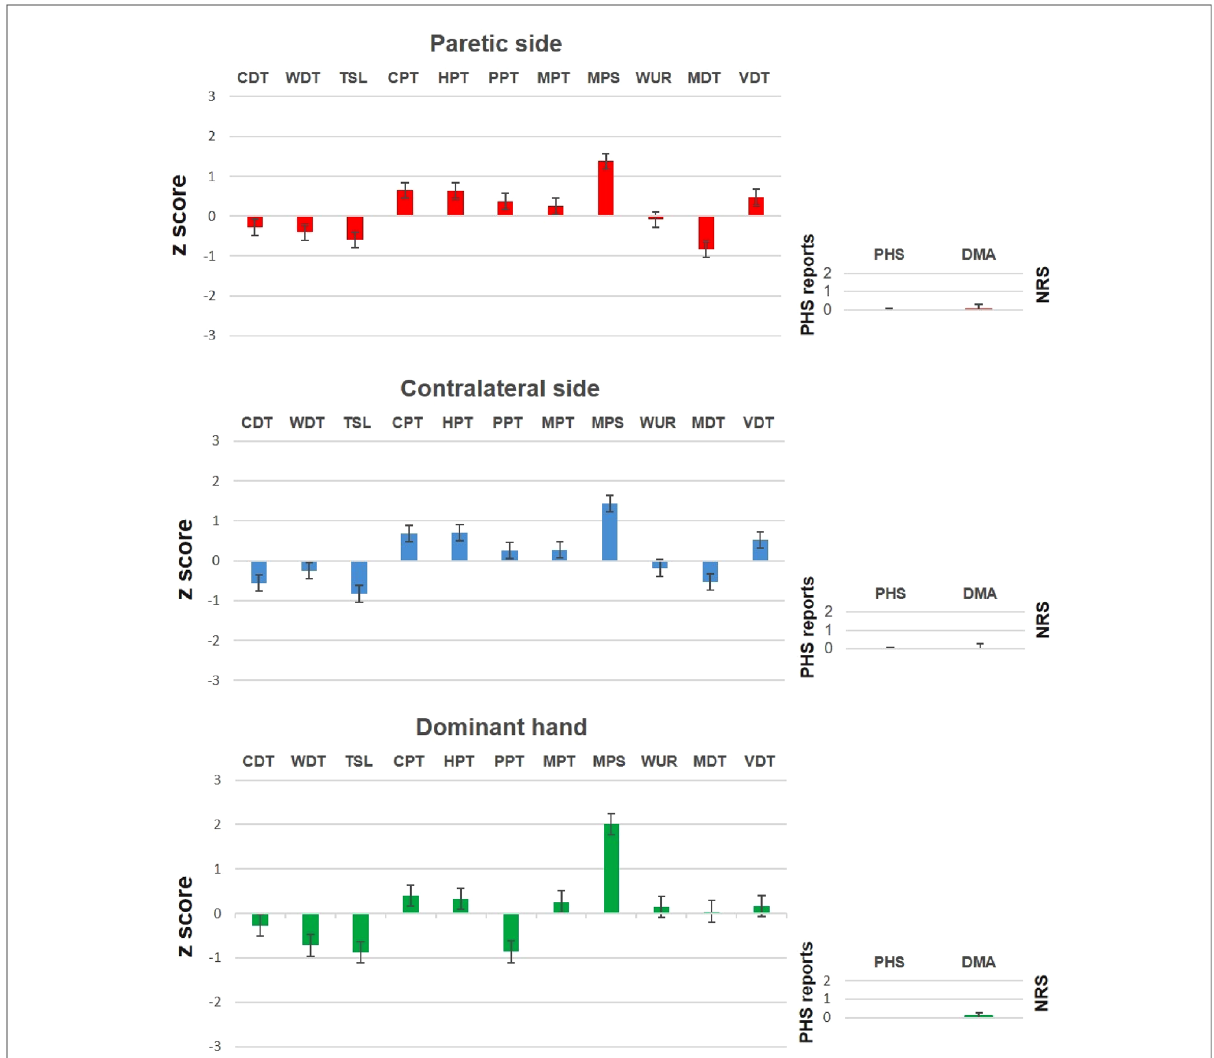
FIGURE 2 The somatosensory z -pro fi les of the paretic side (upper row), the contralateral side (middle row), and the dominant hand (lower row) in patients with facial palsy compared with controls. PHS and DMA were not z -transformed and are presented as raw data. Data are mean±standard error. CDT, cold detection threshold; WDT, warm detection threshold; TSL, thermal sensory limen; CPT, cold pain threshold; HPT, heat pain threshold; PPT, pressure pain threshold; MPT, mechanical pain threshold; MPS, mechanical pain sensitivity; WUR, wind-up ratio; MDT, mechanical detection threshold; VDT, vibration detection threshold; PHS, paradoxical heat sensation; DMA, dynamical mechanical